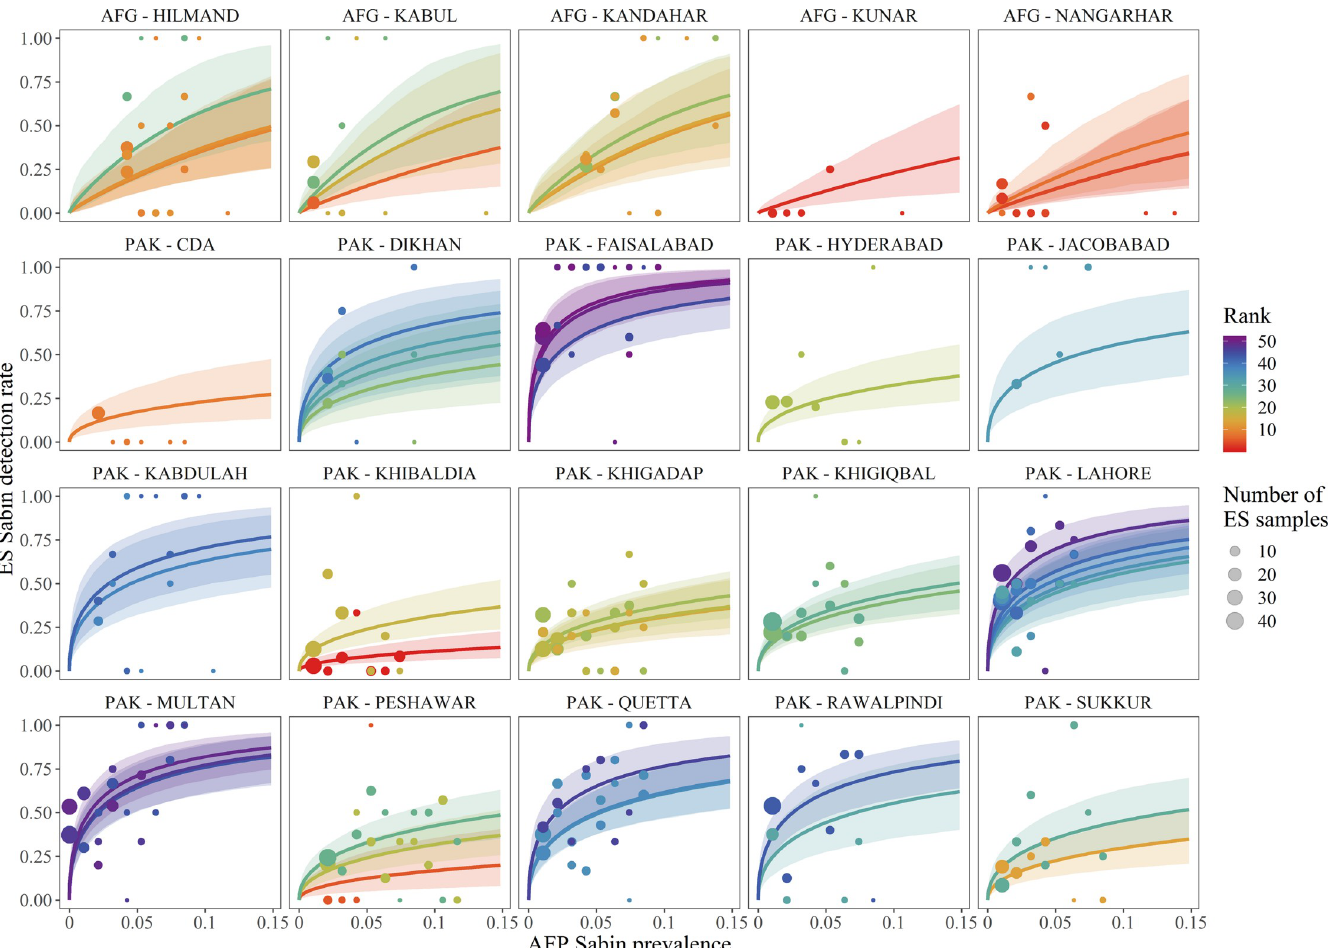
Fig 3. ES sensitivity curves for SL1 for each ES site in Pakistan. ES detection rates (sensitivity) of SL1 increase rapidly with increasing virus prevalence. The dots represent observed rates of Sabin detection from ES data and prevalence estimates based on AFP modeling. The dots are scaled to the number of samples. The solid lines represent mean model predictions for each ES site and the ribbons represent 95% credible intervals. Data and model estimates are colored by ES site from least sensitive (red) to most sensitive (purple). Sites were ranked based on their detection rates at the median predicted Sabin prevalence (0.03). Facets group ES sites at the province level within Afghanistan (AFG) and district level in Pakistan (PAK). See Fig F-H in S1 Text for the corresponding plots for SL2, SL3, and NPEV.